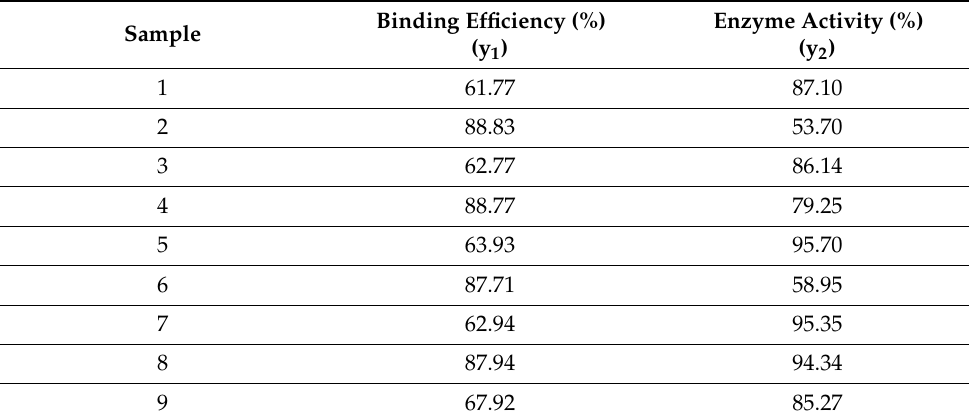
Table 4. Binding efficiency and enzyme activity results (2 3 full factorial